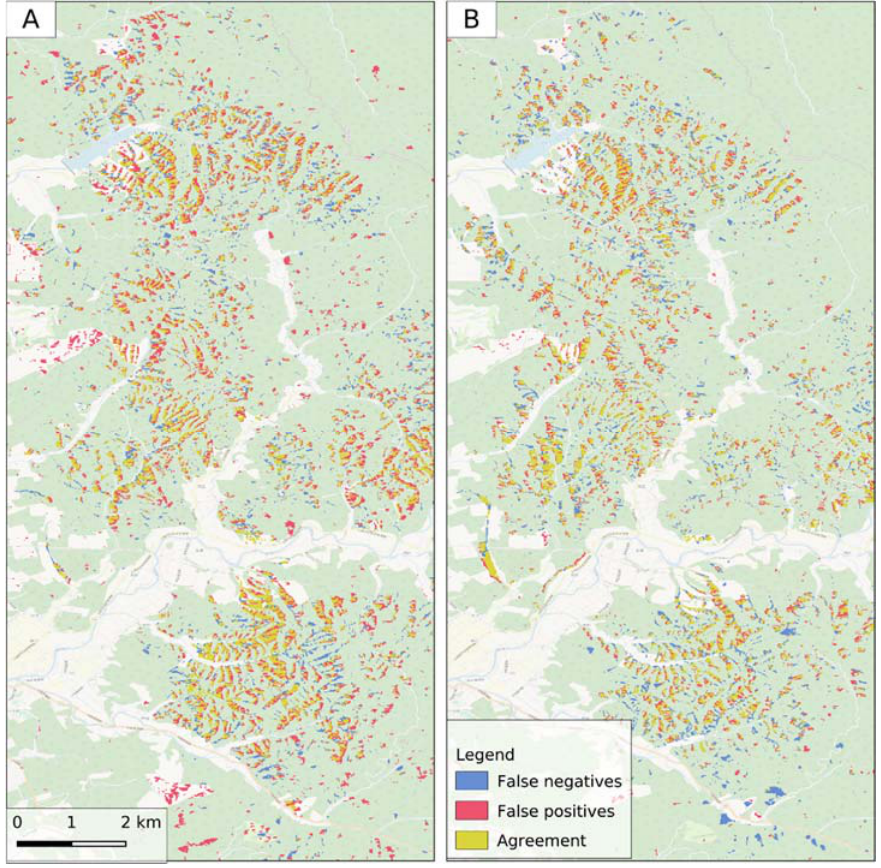
Figure 10. Results of image classification in ascending ( A ) and descending ( B ) geometries. A, the classification of the MTF of the full event. B, the classification of MTF of the co ‐ event imagery. © OpenStreetMap contributors.